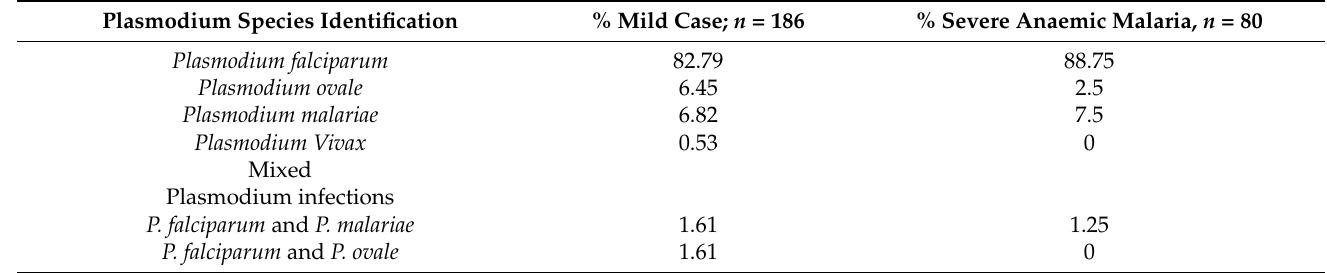
Table 1. Diversity of Plasmodium species present in each group of